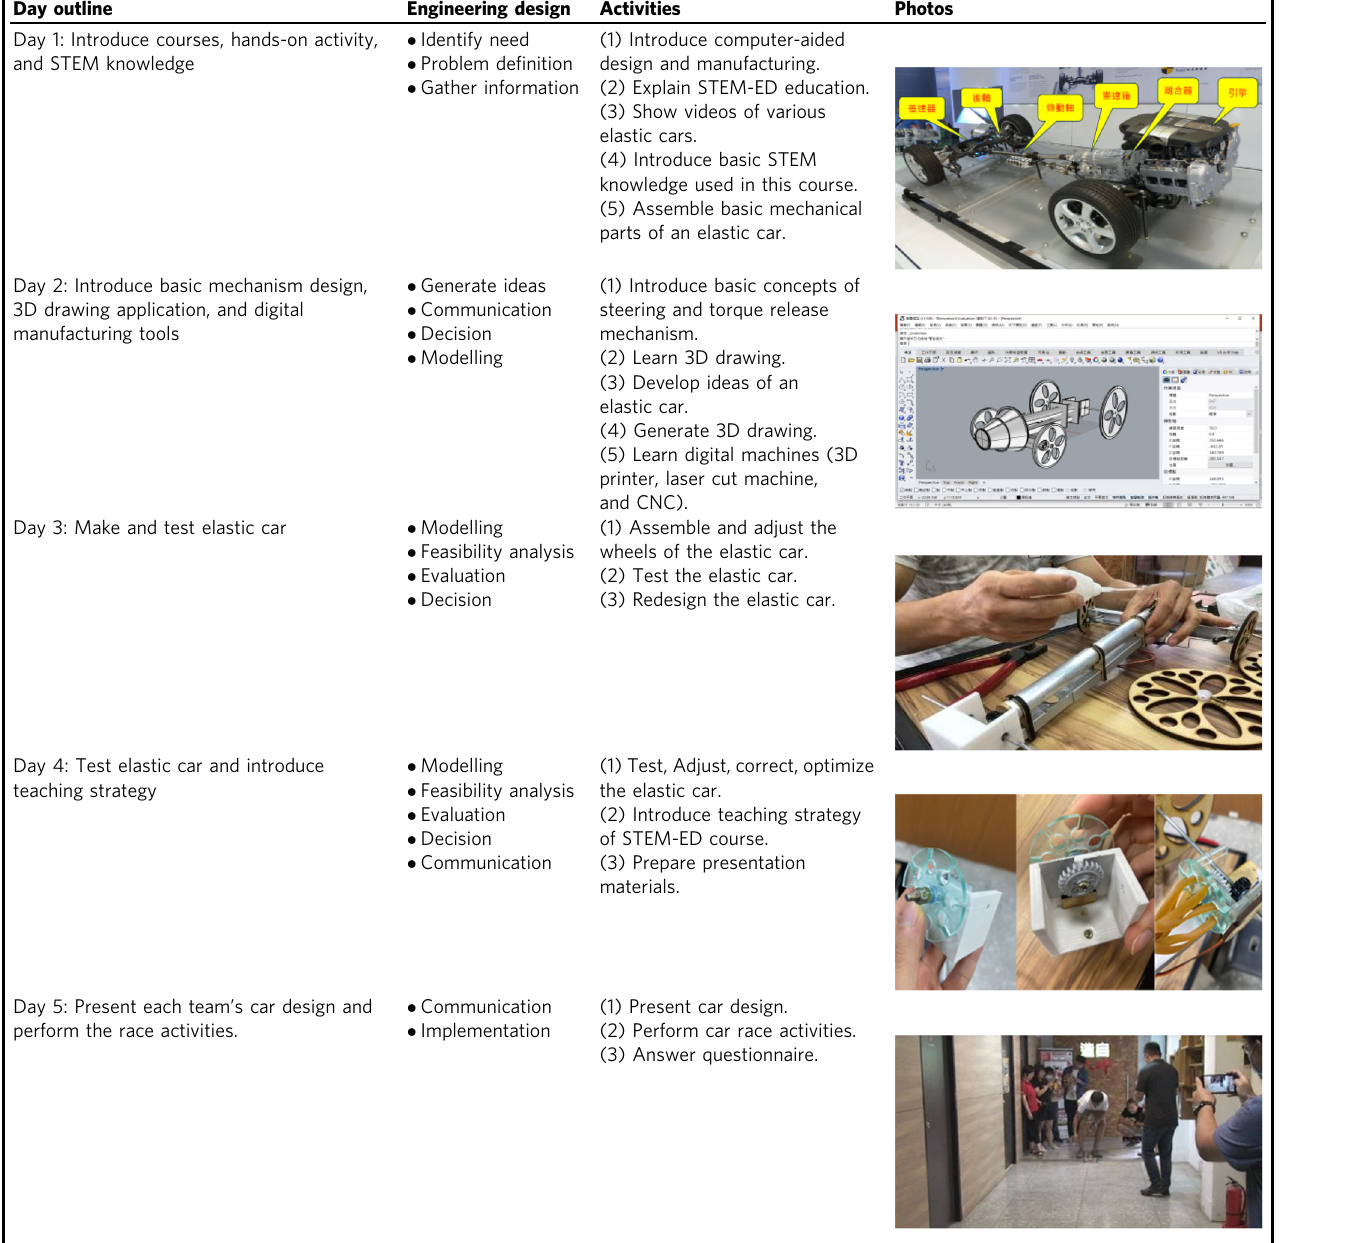
table internal consistency and reliability.